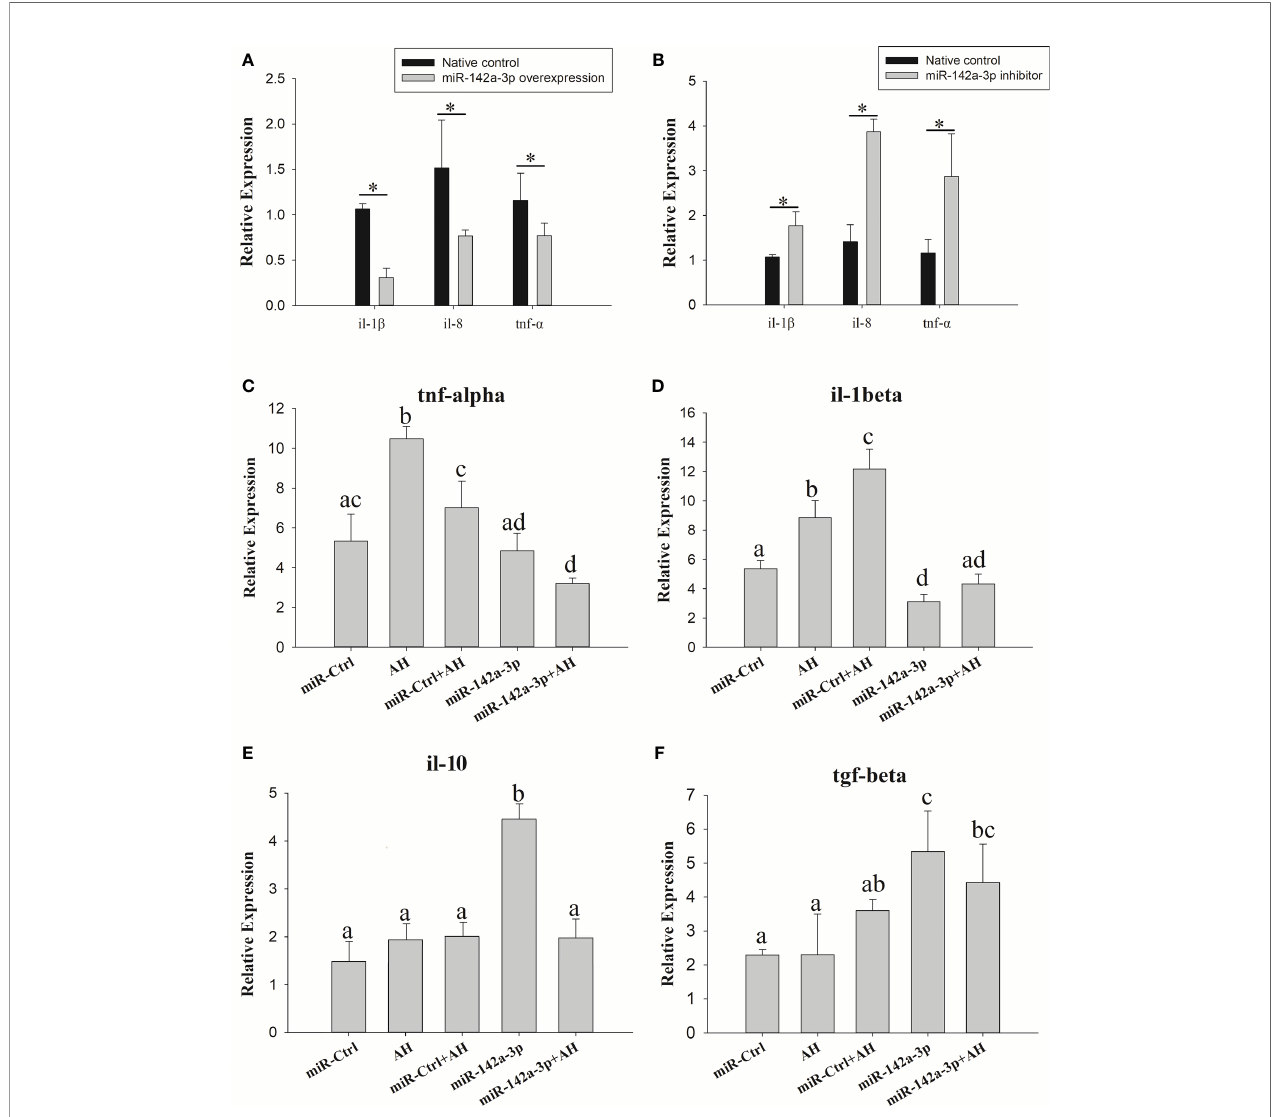
FIGURE 5 | Grass carp cells (CIK) were transfected with either the miR-142a-3p agomir (A) or antagomir (B) . After 48 h, the level of tnf- a , il-1 b , and il-8 expression was determined using qPCR. Kupffer cells were transfected with miR-142a-3p agomir or control solution, and then the Kupffer cells were infected with Aeromonas hydrophila. The mRNA levels of il-1 b , tnf- a , il-10, and tgf- b (C – F) were analyzed by qRT-PCR 6 h after infection. All values represent the mean ± SD of three independent experiments. Different lowercase letters indicate statistically signi fi cant differences ( p < 0.05). Asterisks indicate signi fi cant differences (* p < 0.05). AH, A. hydrophila